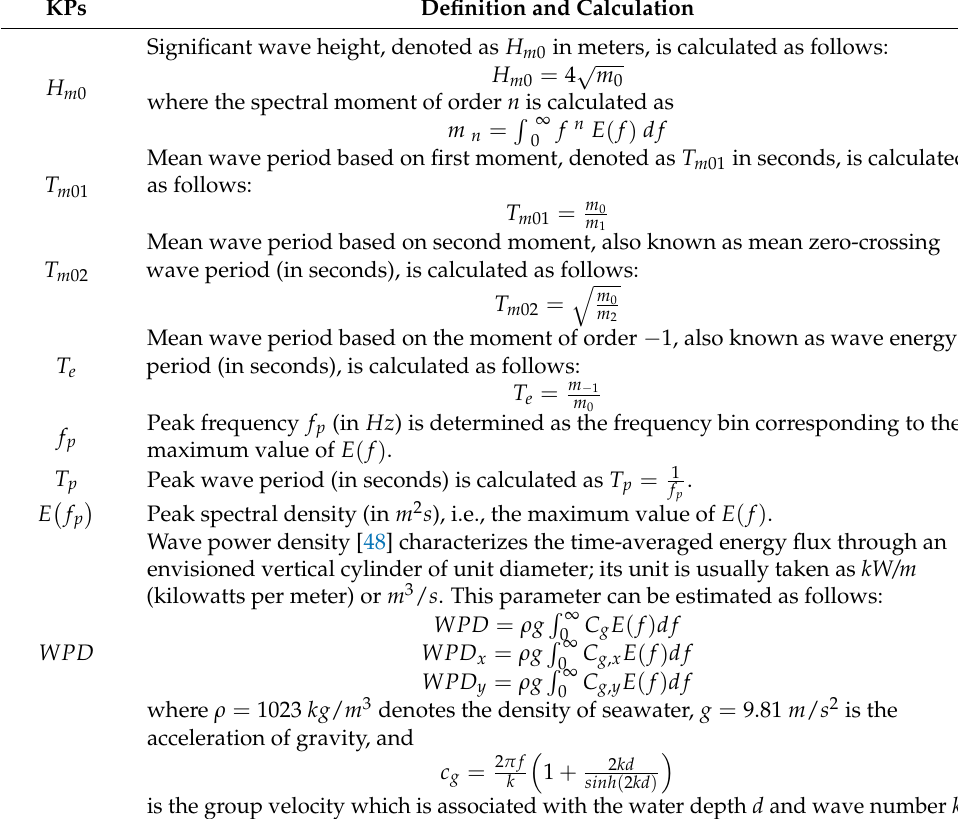
Table 2. KPs adopted to represent the characteristics of spectra and